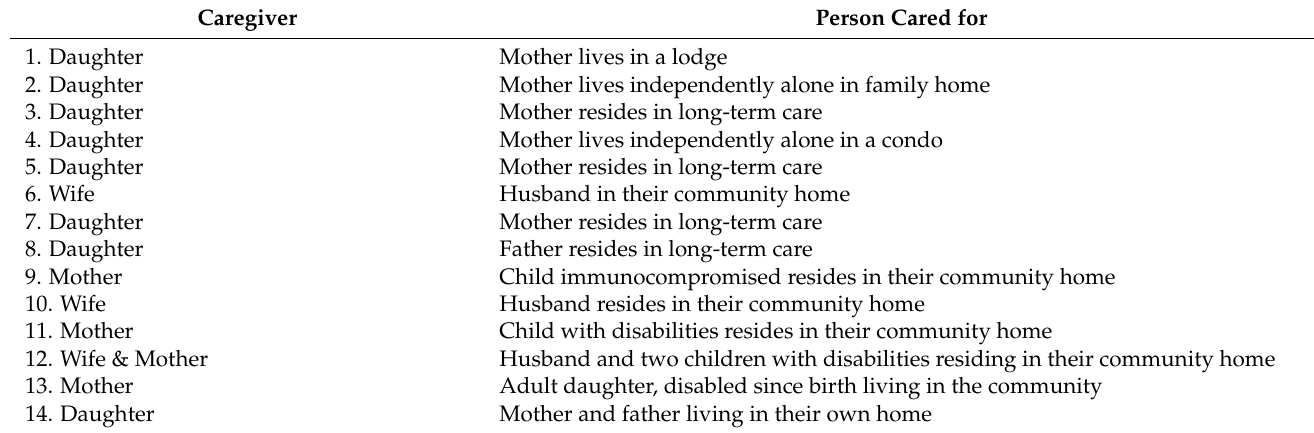
Table 1. Demographics qualitative